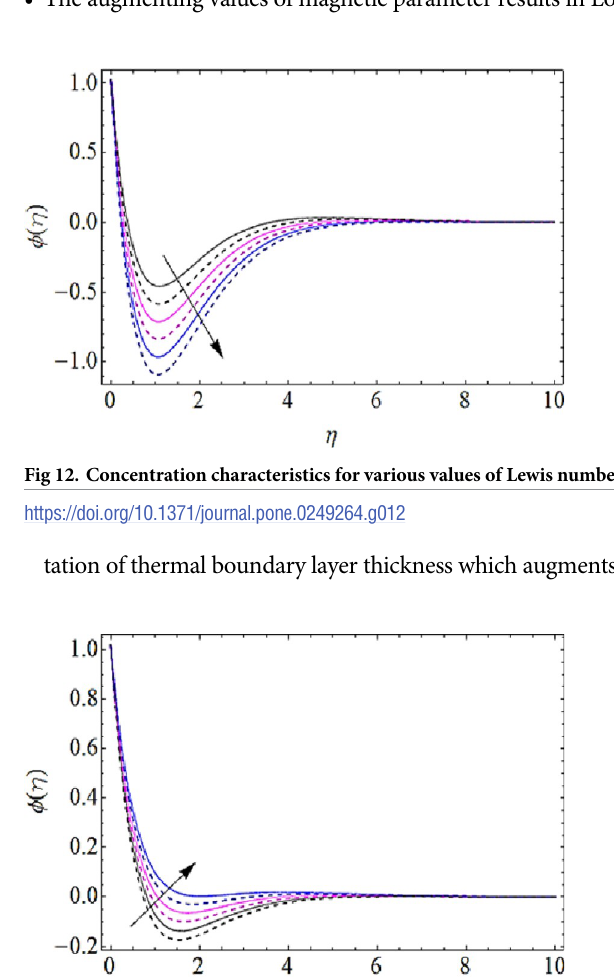
• The augmenting values of magnetic parameter results in Lorentz force that leads to an augmen-